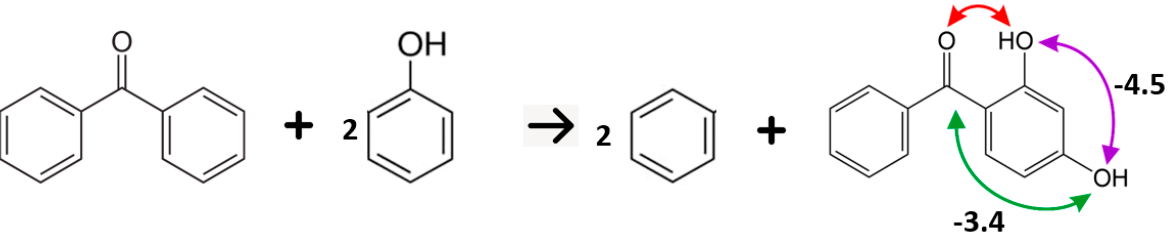
Figure 13. Determination of the intra-molecular hydrogen bonding strength in 2,4-di-hydroxy- benzophenone using the “well-balanced reaction” method. The reaction enthalpy ∆ r H o m(WBR) = − 32.2 kJ · mol − 1 (see Table 10, column 2). Additional interactions para C = O ( C 6 H 5 ) − OH = − 3.4 kJ.mol − 1 and